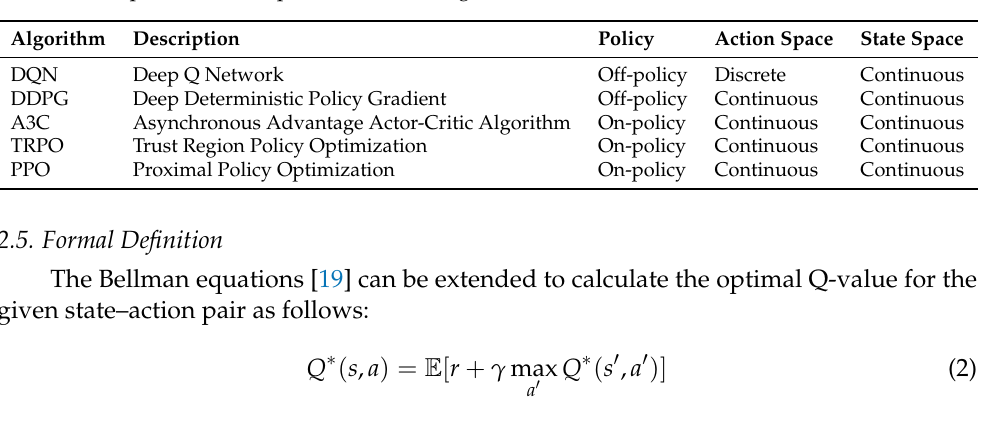
Table 2. Comparision of deep reinforcement